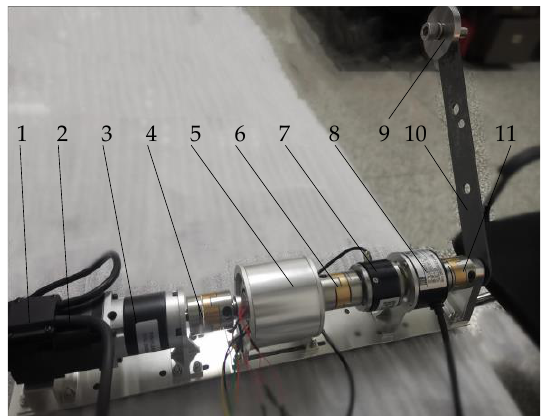
Figure 17. Internal diagram of the variable stiffness joint and the variable stiffness actuator.